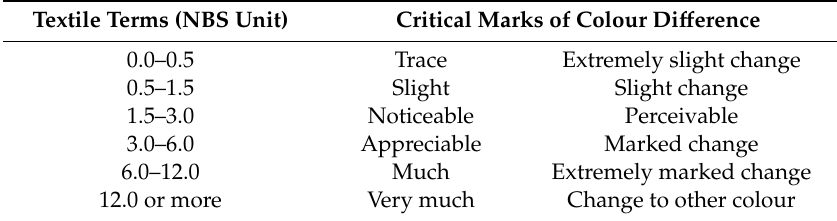
Table 2. Critical marks of colour di ff erence according to the National Bureau of Standards [9,20,21].